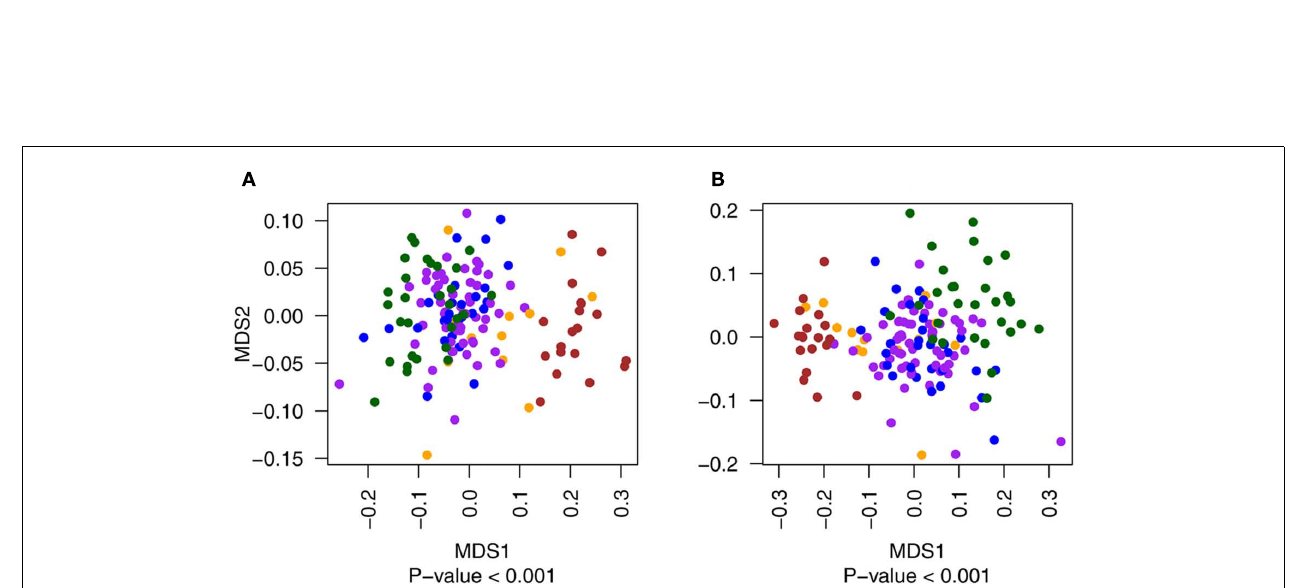
(green) tissues for exonic (A) and non-exonic (B) features. Metastatic and normal data points are included in the figure for illustrative purposes